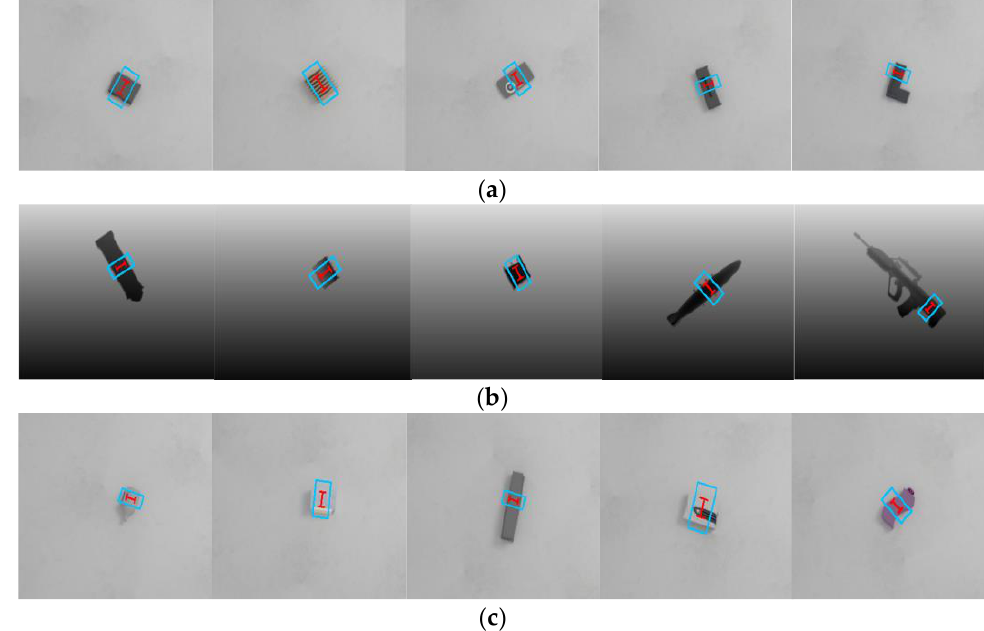
Figure 6. Grasping detection results on the Jacquard grasp dataset: ( a ) the results using RGB images, ( b ) the results using depth images, ( c ) the results using RGB-D images. The blue rectangle refers to the opening width when the gripper approaches the object, and the red “I” represents the closing width when the gripper picks up the object.